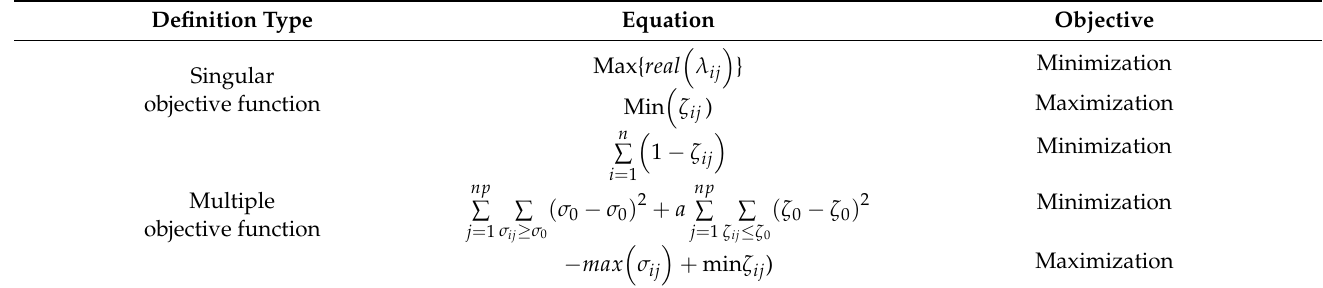
Table 3. Objective function definition approaches.